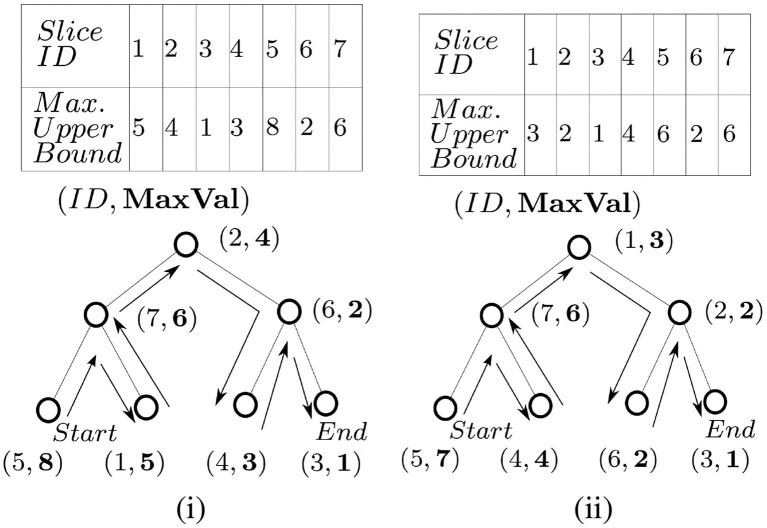
SliceUpperBoundBST at time (i)
t1 and (ii)
t2.